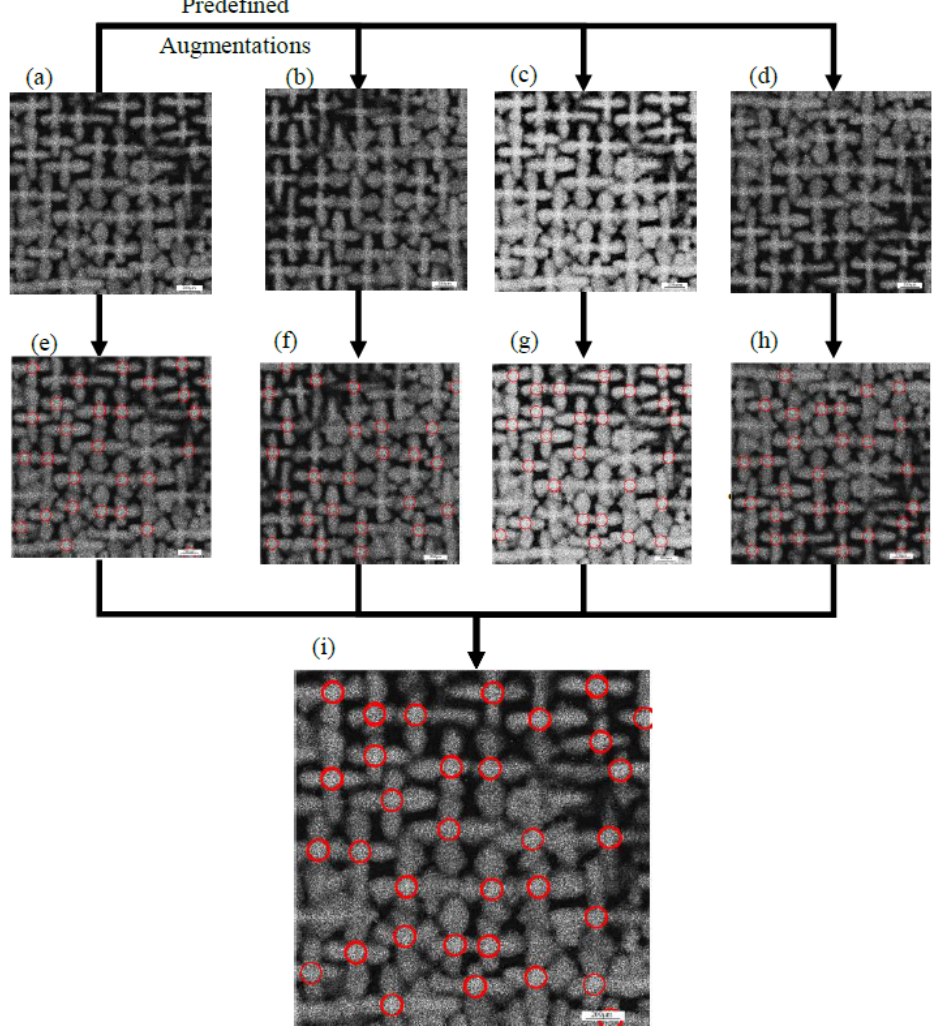
Figure 5. The extraction result of the dendrite cores in a single field of view by TTA. ( a ) is the original image; ( b – d ) are the augmented images; ( e – h ) are the results which were extracted by Faster R-CNN; ( i ) is the final result.